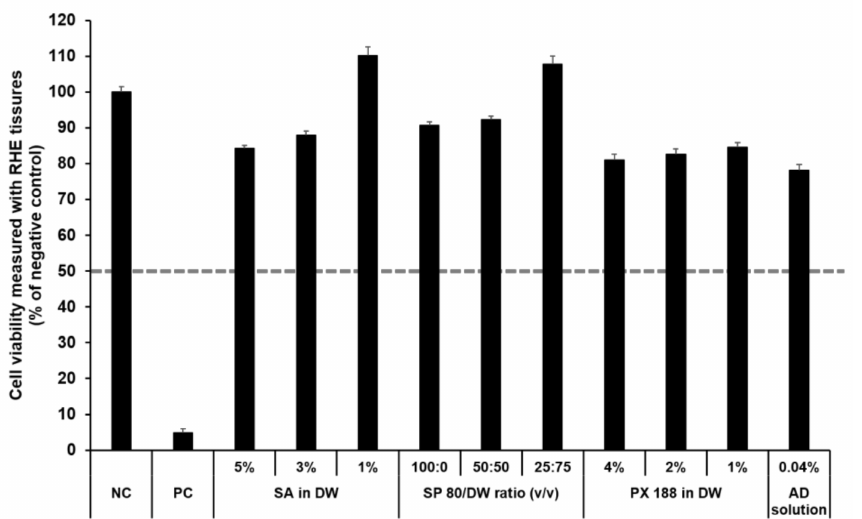
Figure 10. Viability of SkinEthic RHE tissue treated with SLN components and AD solution. The cell viability was measured using MTT assay. The values greater than 50% (dotted line) indicate that test materials are non-irritant to the skin. Results are expressed as means ± standard deviations of three independent experiments ( n = 3). NC: DPBS; PC: 5% SDS solution; SA: Stearic acid; DW: Distilled